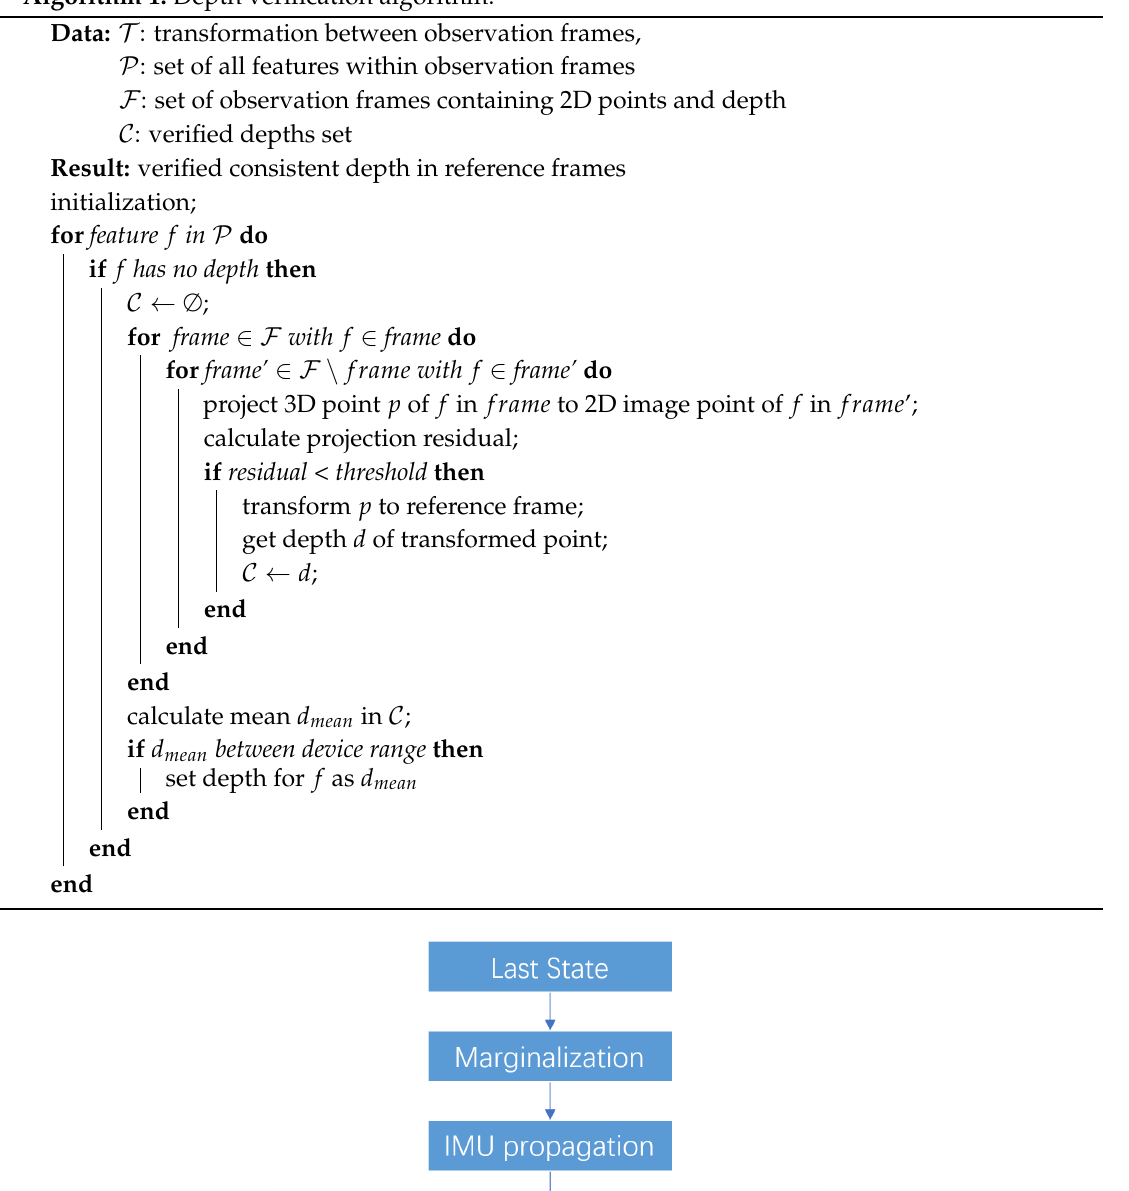
Algorithm 1: Depth verification algorithm.